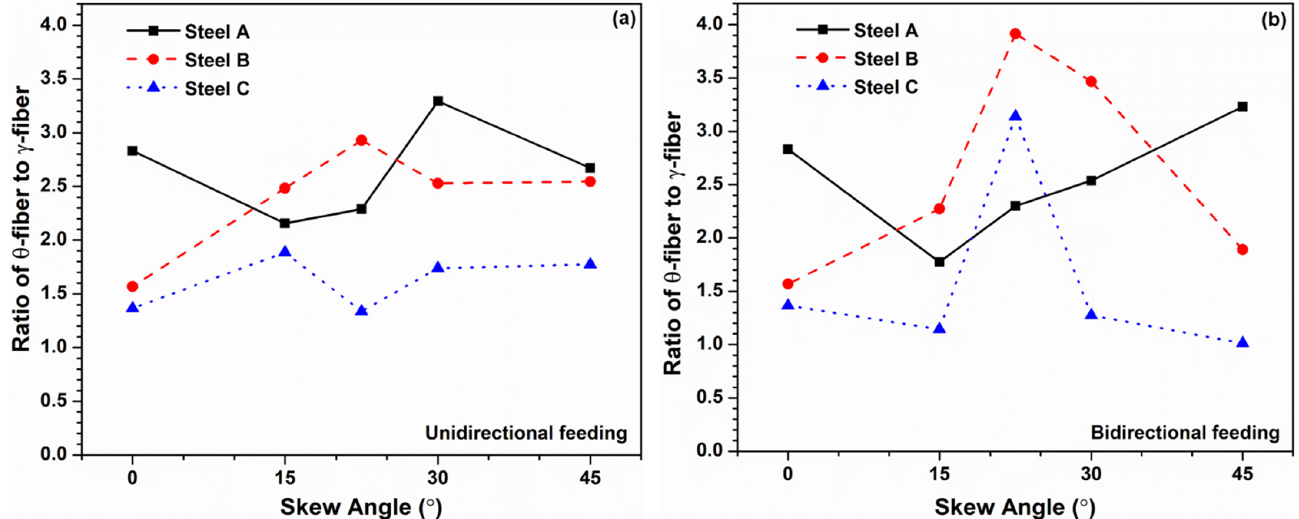
Figure 12. Effect of skew rolling angle on the texture factor (ratio of the θ -fiber to γ -fiber) of non- oriented electrical steels after annealing: ( a ) unidirectional feeding; ( b ) bidirectional